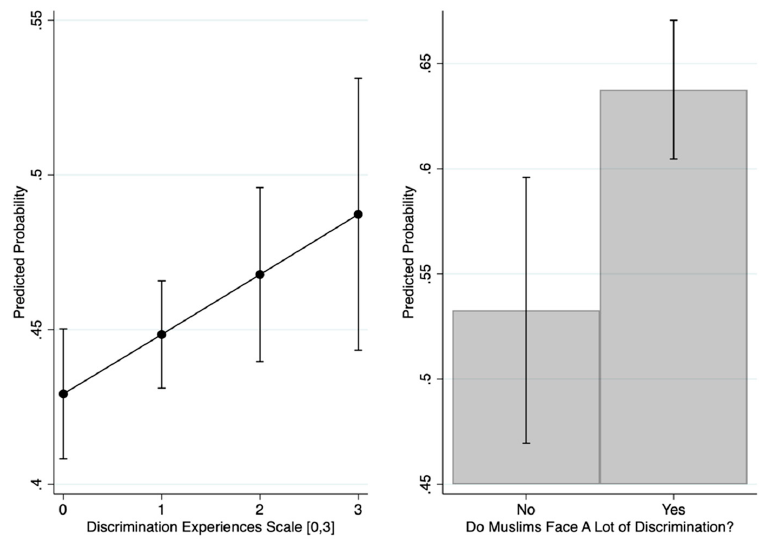
Figure 3. Predicted probability of believing homosexuality should be accepted by society, computed from models 1 (left) and 2 (right) of Table 3, which utilize all three survey years (2007, 2011, and 2017) and include controls for age, gender, ethnicity, generation, income, mosque attendance, frequency of prayer, and political ideology.